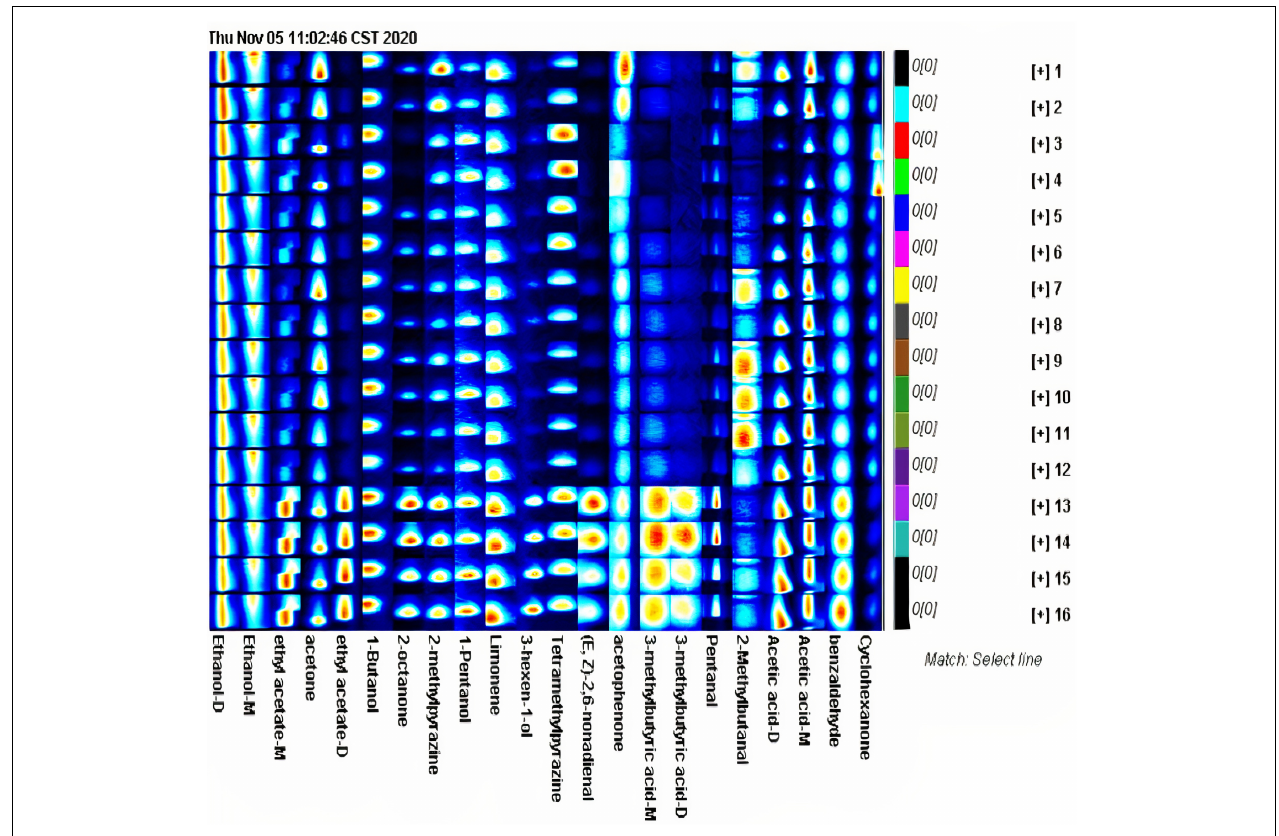
FIGURE 3 | The Gallery Plot (fingerprint spectrum) of asparagus root samples with different drying methods.